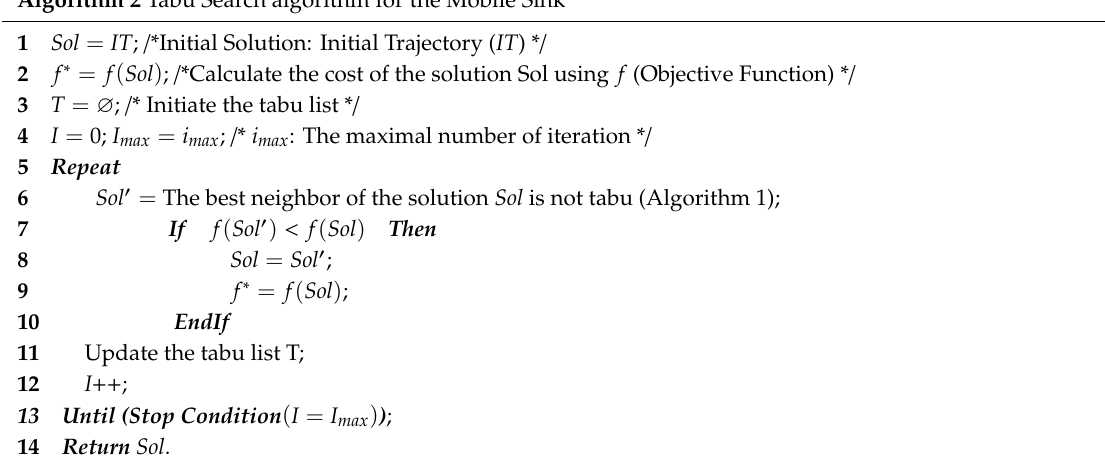
Algorithm 2 Tabu Search algorithm for the Mobile